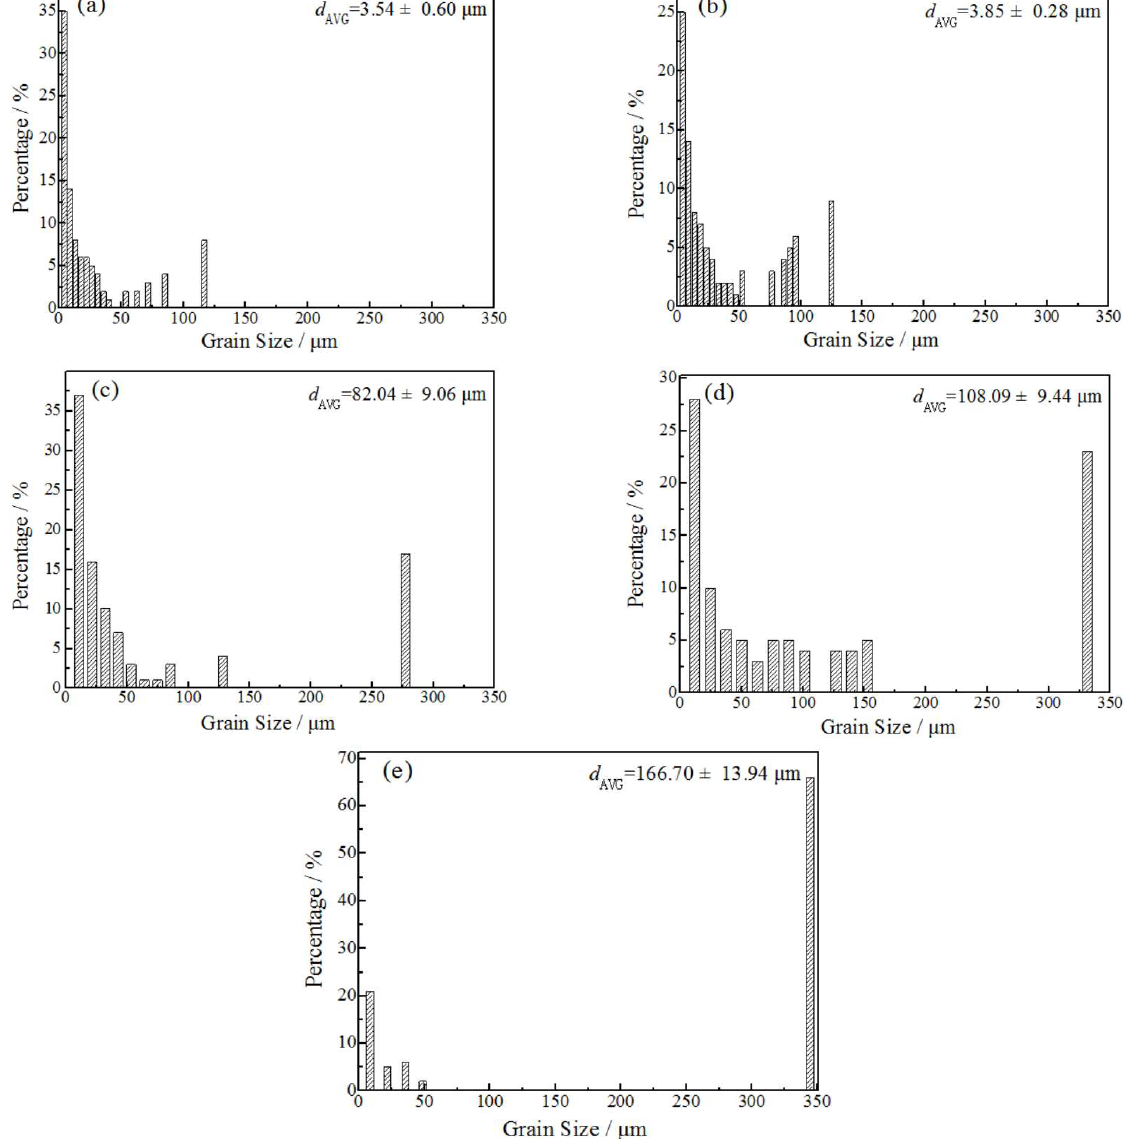
Figure 6. Effect of annealing time on the grain size of rolled and annealed copper foil. ( a ) Rolled sample; ( b ) 1 min; ( c ) 5 min; ( d ) 10 min; ( e ) 60 min.